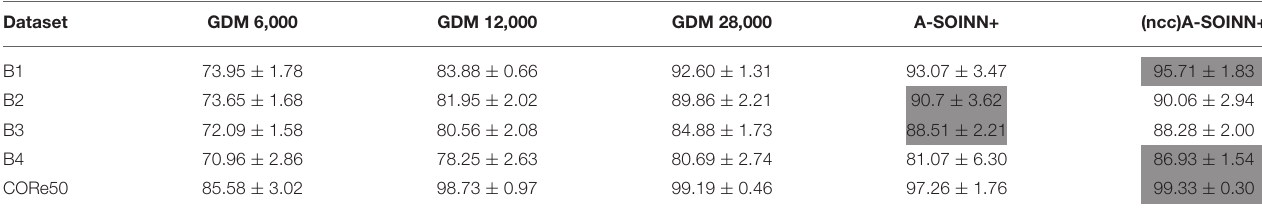
The gray shaded entries represent the highest values for each